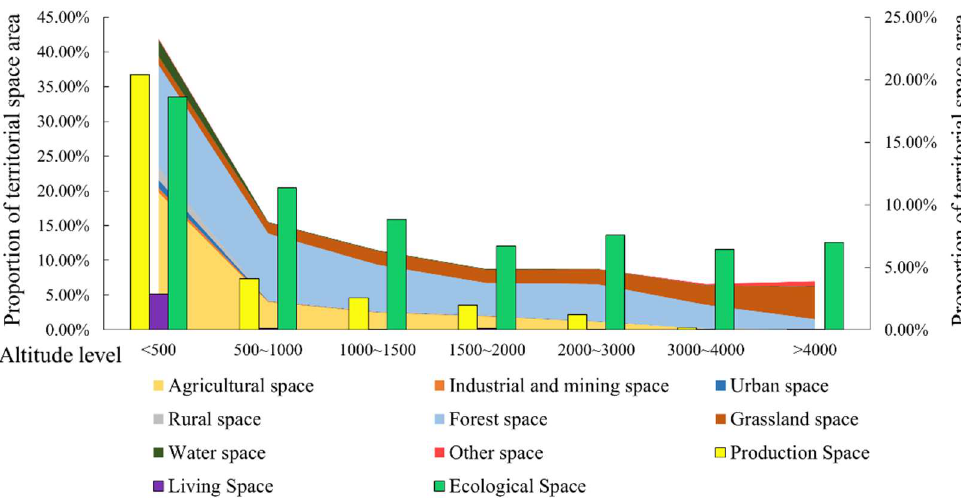
Figure 3. Proportion of territorial space area on the elevation gradient of the Yangtze River Economic Belt from 2000 to 2020.